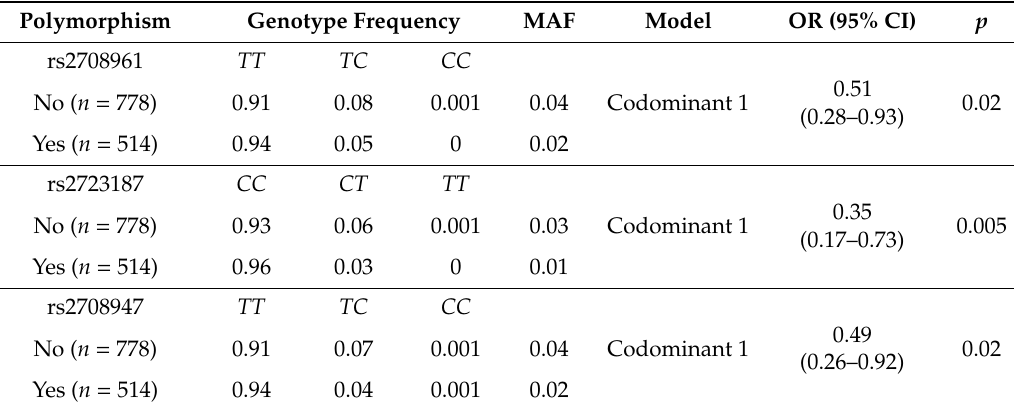
Table 2. Association of IL-37 gene polymorphisms with hypercholesterolemia